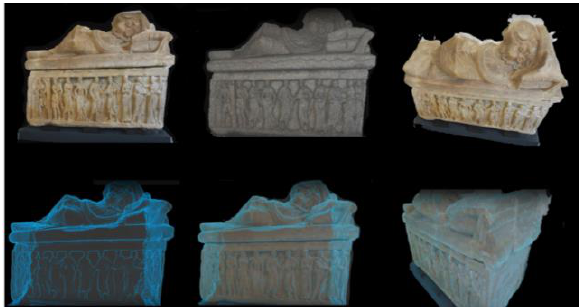
Figure 13. Sarcophagus 3D model